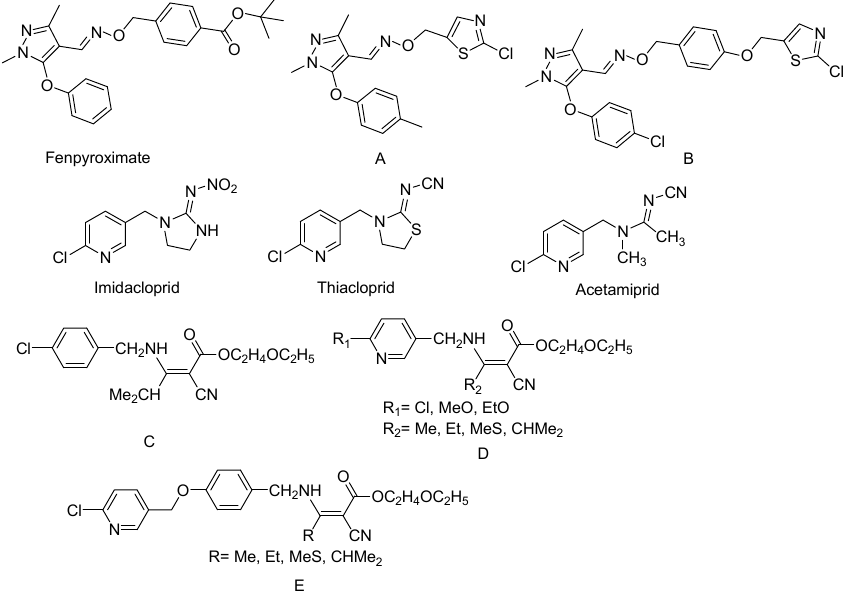
Figure 1. Structures of fenpyroximate, imidacloprid, thiacloprid, acetamiprid, and compounds A – E .